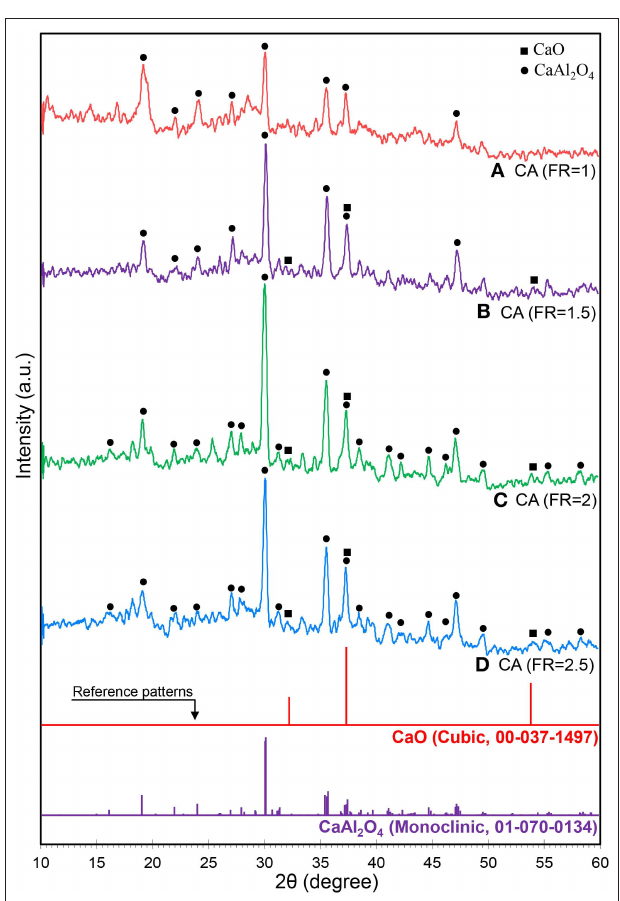
FIGURE 2 | XRD patterns of synthesized CaAl 2 O 4 supports with various fuel ratios: (A) CA (FR = 1), (B) CA (FR = 1.5), (C) CA (FR = 2), and (D) CA (FR =